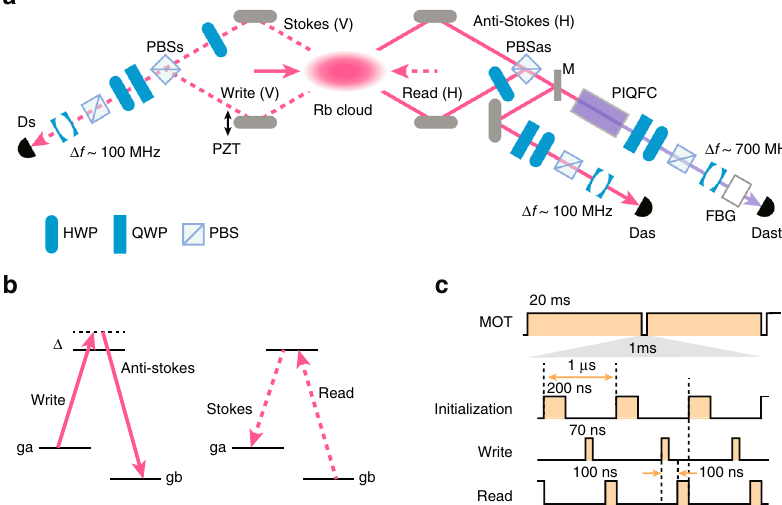
Fig. 2 Experimental setup. a Our experimental setup for entanglement between Rb atoms and visible/telecom photons without/with QFC. When mirror M is fl ipped up, AS photon is detected by D as without QFC. When mirror M is fl ipped down, AS photon is input to polarization-insensitive QFC (PIQFC) as shown in Fig. 1d and then the converted photon is detected by D ast . In order to stabilize the interferometer in optical paths of Stokes and anti-Stokes photons, we use a conventional diode laser at a center wavelength of 850 nm (not shown). The light enters into the interferometer from the vacuum port of PBS s , and then after passing along the same four optical paths for Stokes and anti-Stokes photons, it comes from the vacuum port of PBS as . The light is detected by a photo detector, and its detection signal is used for feedback control of the interferometer by a mirror on a Piezo stage (PZT). b Λ -type energy levels of D 2 line in 87 Rb used in our experiment. The ground levels of g a and g b correspond to the levels of 5 2 S 1/2 , F = 2 and 5 2 S 1/2 , F = 1, respectively. The excited level is 5 2 P 3/2 , F ′ = 2. Δ is set to ~10 MHz. The magnetic sublevel is degenerated in our experiment due to the absence of the magnetic fi eld, and the polarization selection of write, read, AS and S light is to extract larger amounts of the emitted photons under an assumption that the initialized atomic states in g a are fully mixed over the magnetic sublevels (Supplemental Material in ref. 29 ). c Time sequence of the experiment. The quantum experiment is performed within 1 ms during the MOT is turned off. The period of the two initialization pulses is 1 μ s and the injection of them is repeated 990 times